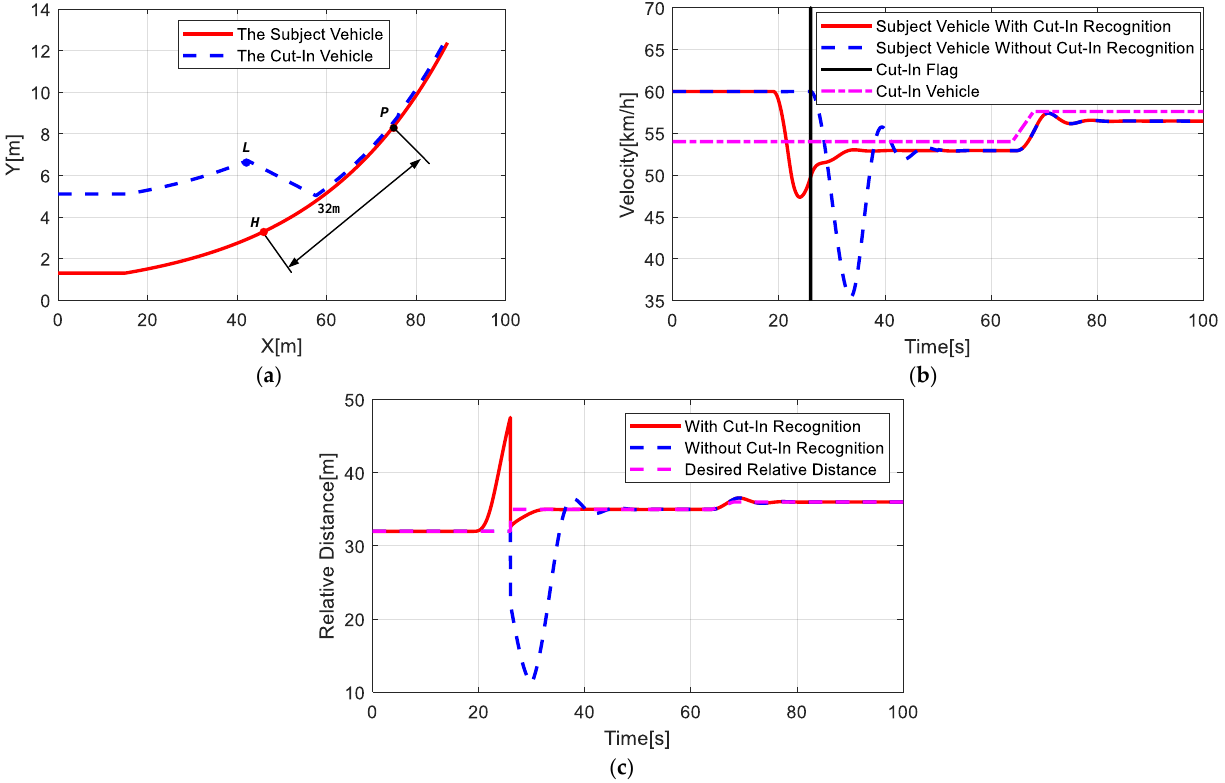
Figure 16. The simulation results of driving scenario 3: ( a ) vehicle positions of cut-in within safe distance; ( b ) the velocity of the subject vehicle and the cut-in vehicle; ( c ) the relative distance between vehicles.